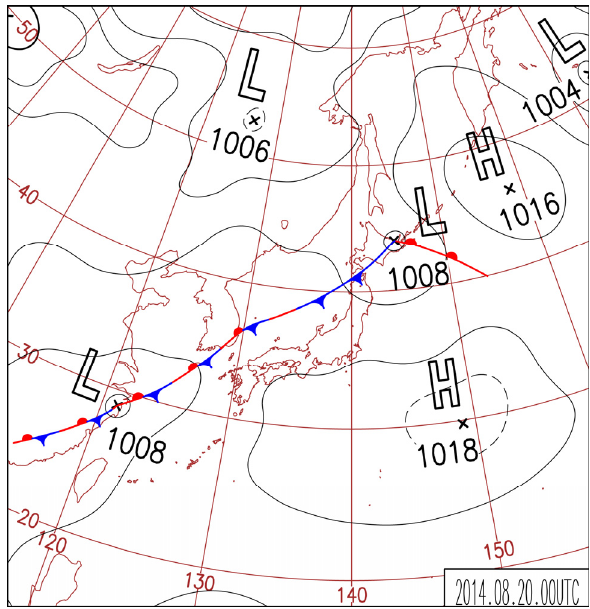
Figure 2. JMA weather chart (0:00 August 20,